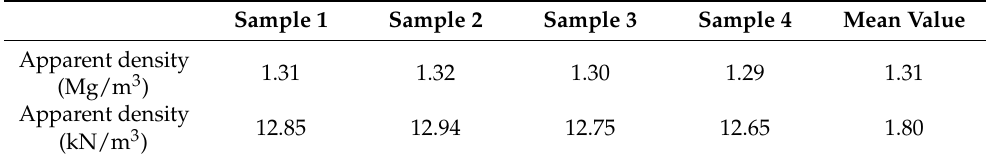
Table A1. Determination of the apparent